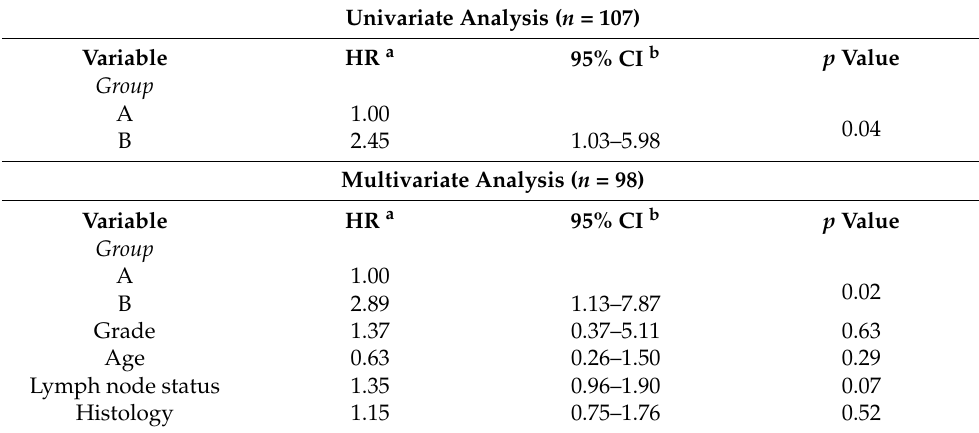
Table 5. Cox univariate and multivariate regression analysis for the prediction of disease-free survival (DFS) after stratification of study cohort according to combination of the rs822336 G>C and rs822337 T>A genotypes.